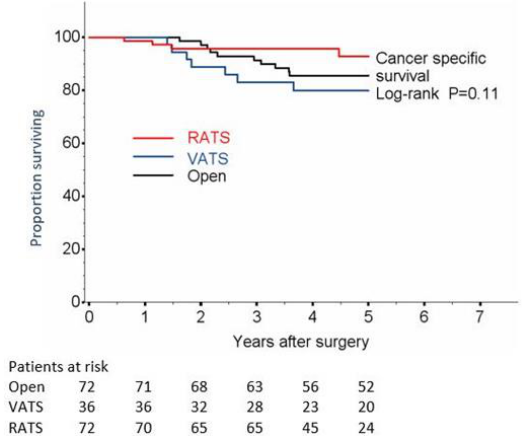
Figure 3. Lung Cancer-Specific